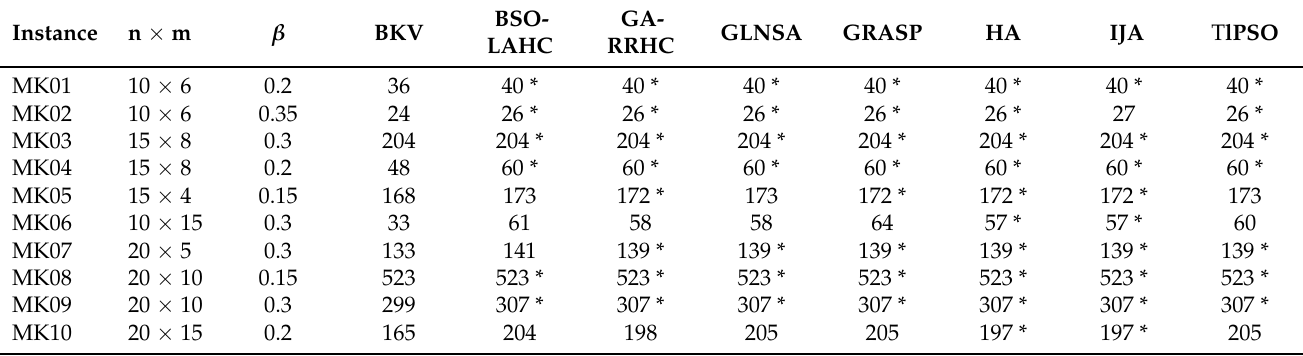
Table 5. BRdata dataset